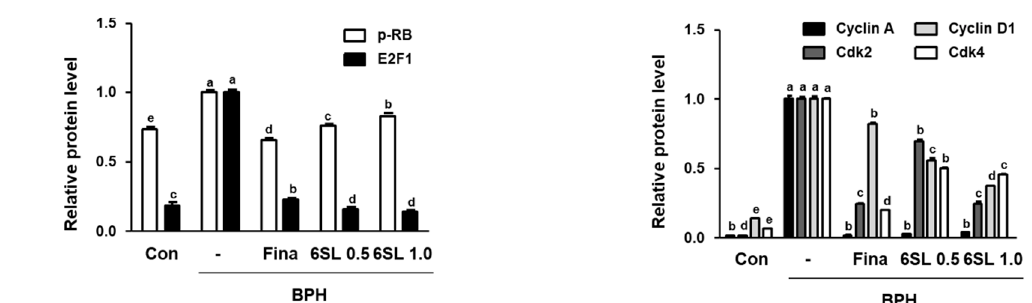
Figure 3. Effect of 6SL on E2F transcription factor 1 (E2F1)-relative and cell cycle protein expression in TP-induced BPH rat model. ( A ) The manifestation of retinoblastoma protein (pRb) in prostatic tissues from rats was shown by immunohistochemistry. The immunoblotting images and quantitative analysis show the protein expression of ( B ) pRb, E2F1, and ( C ) cyclin A, cdk2, cyclin D1, Cdk4. The densities of proteins were calculated using ImageJ Software. Relative protein level represents densitometric values of each protein as ratio to β -actin. Values with different letters indicate significant differences, p < 0.05.